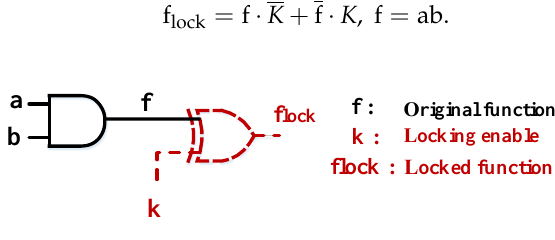
Figure 4. A simple example of logic